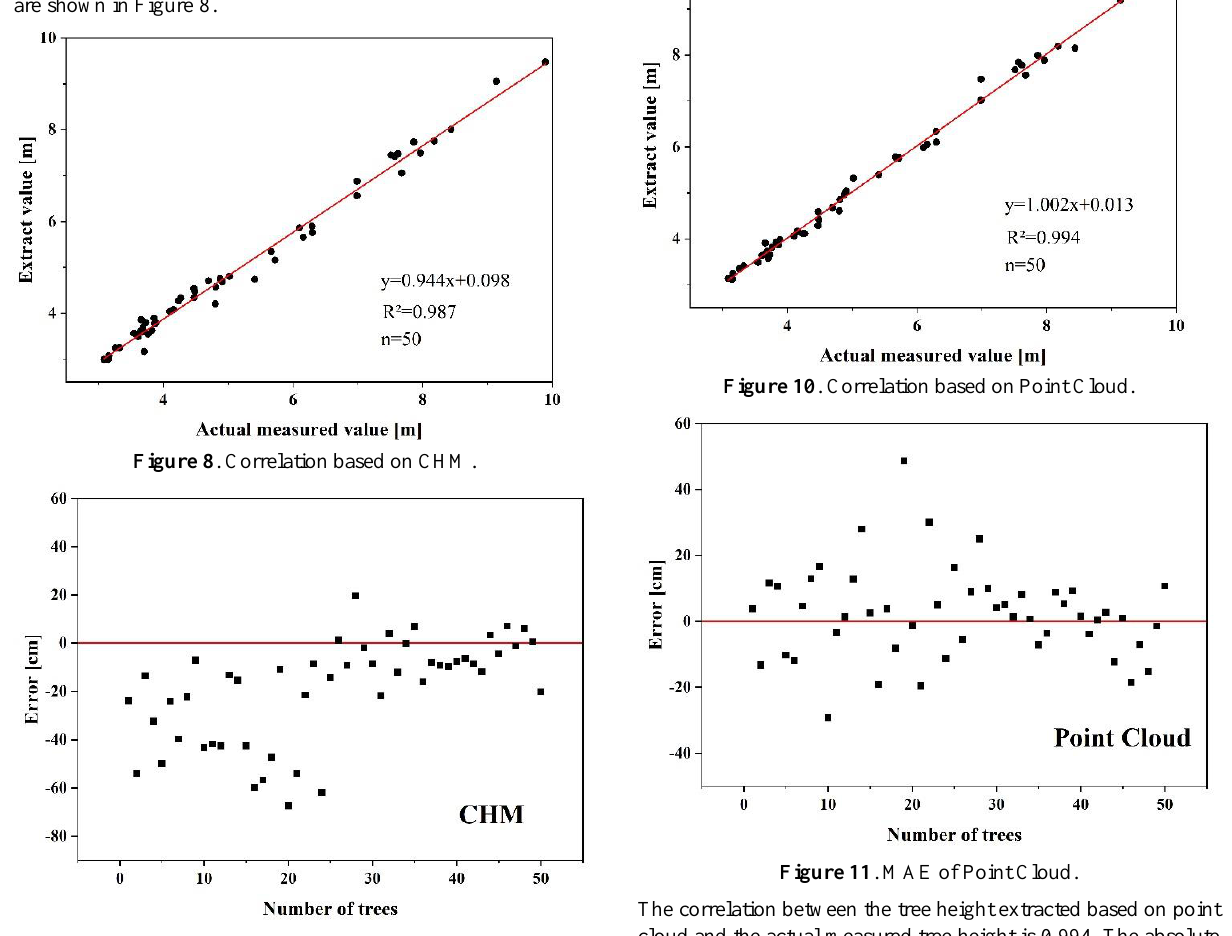
Figure 9 . MAE of CHM.